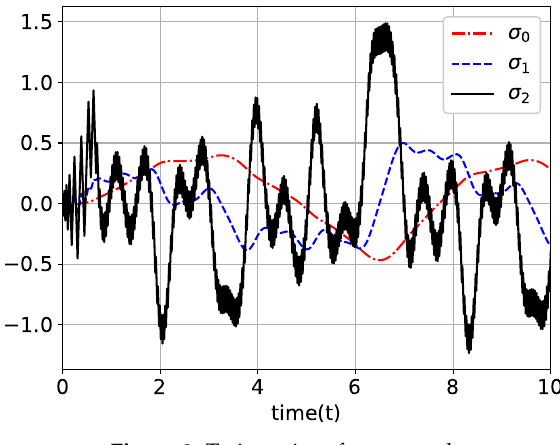
Figure 3. Trajectories of σ 0 , σ 1 , and σ 2 .